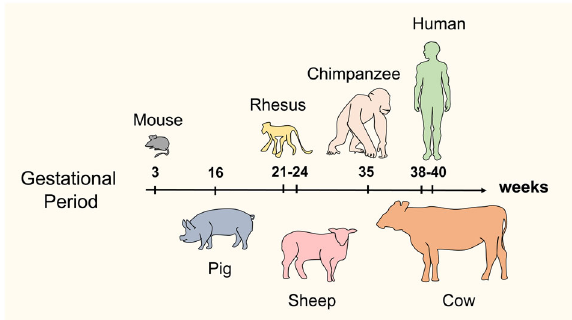
Fig. 4 Comparative gestational periods of candidate hosts for human – animal interspecies chimera development. Mouse (18.5 days), pig (114 days), sheep (152 days), nonhuman primate (NHP) rhesus monkey (166 days), NHP chimpanzee (243 days), human (280), cow (283 days) 128